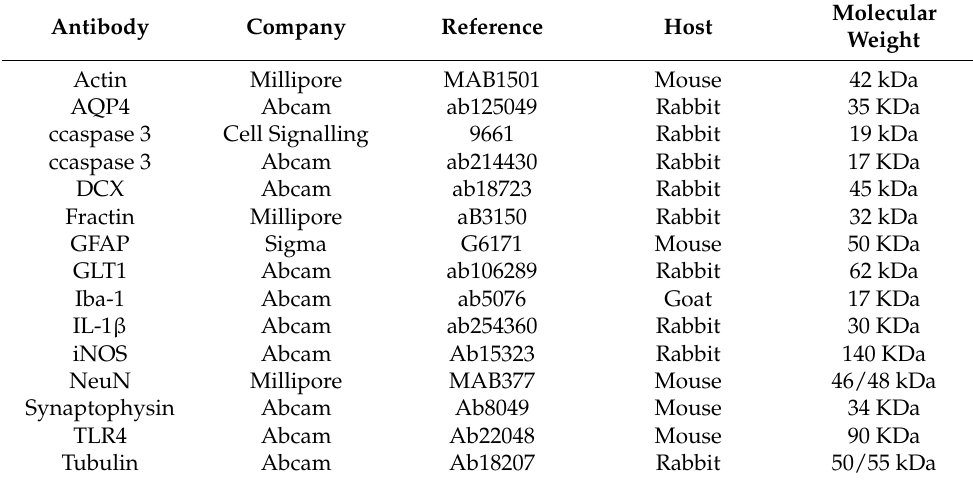
Table 1. List of primary antibodies used. List of abbreviations for the antibodies: AQP4, aquaporin 4; ccaspase 3, cleaved caspase 3; DCX, doublecortin; GFAP, glial fibrillar acid protein; GLT1,